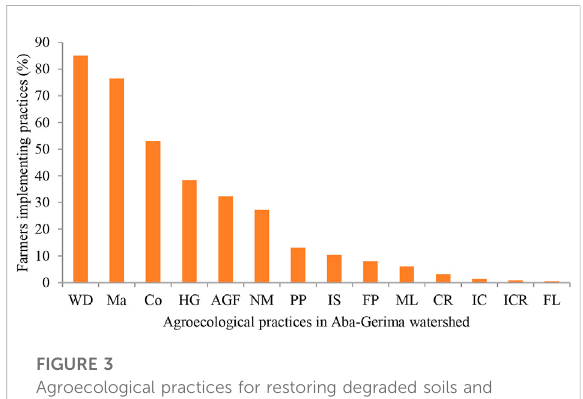
FIGURE 3 Agroecological practices for restoring degraded soils and improving agricultural productivity in Aba-Gerima watershed. WD refers to watershed development activities, Ma, manure; Co, compost; HG, Homegardening; AGF, agroforestry; NM, natural mating; PP, pit planting; IS, improved seeds; FP, feed production; ML, mulching; CR, crop rotation; IC, intercropping; ICR, incorporating crop residues; FL, fallowing.